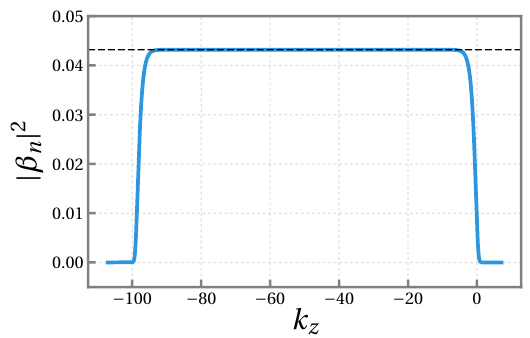
Figure 3 . Particle production encoded in the Bogoliubov coe(cid:14)cient j (cid:12) n j 2 for t (cid:29) (cid:28) as a function of the momentum k z , obtained by solving eq. (3.8) numerically. Here we have adopted units p of g j Q j E = 1, taken (cid:28) = 100 and m T a = 1 in these units and have chosen Q > 0. For comparison, the horizontal black dashed line indicates the value e (cid:0) (cid:25)m 2 T a 2 =g j Q j E , demonstrating excellent agreement with the analytical estimate